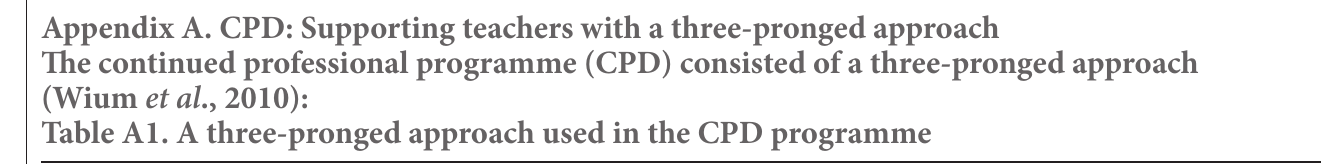
Table A1. A three-pronged approach used in the CPD programme Component Procedure Training component (workshop) ‘Language in numeracy’